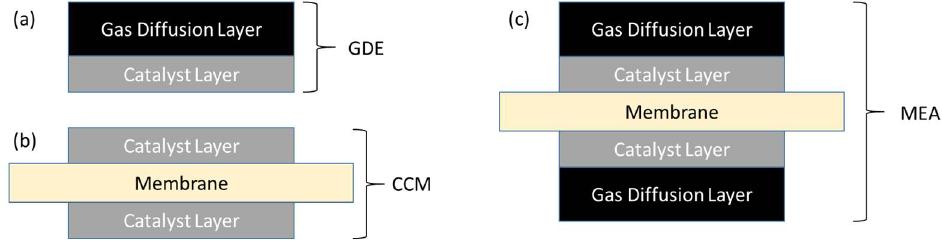
Figure 1. Schematic cross-sectional depiction of membrane–electrode assembly components: ( a ) gas diffusion electrode (GDE) and ( b ) catalyst-coated membrane (CCM) sub-components; ( c ) a fully assembled MEA from either GDE’s + Membrane or CCM + GDL’s.